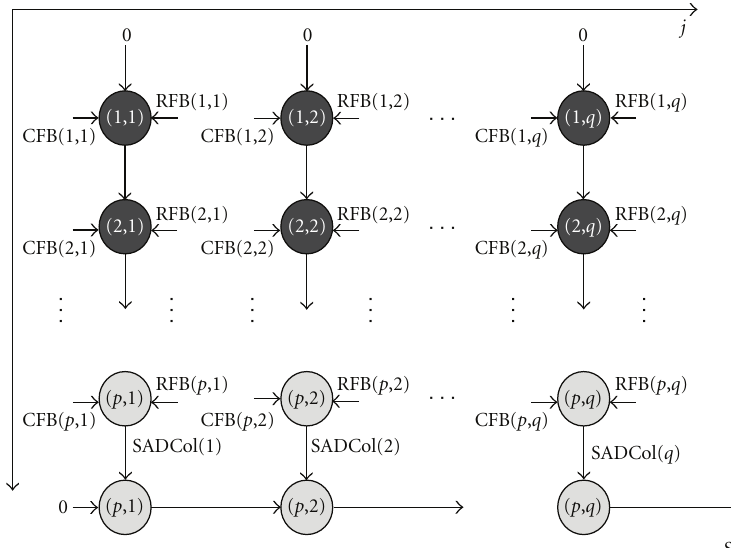
Figure 2: Dependence graph illustrating the SAD computation for block of size p × q . CFB( i , j ) and RFB( i , j ) are reference and current block pixels fed into the system. “Dark” nodes represent computation belonging to (7), and “light” nodes represent computation belonging to (7) and (8).